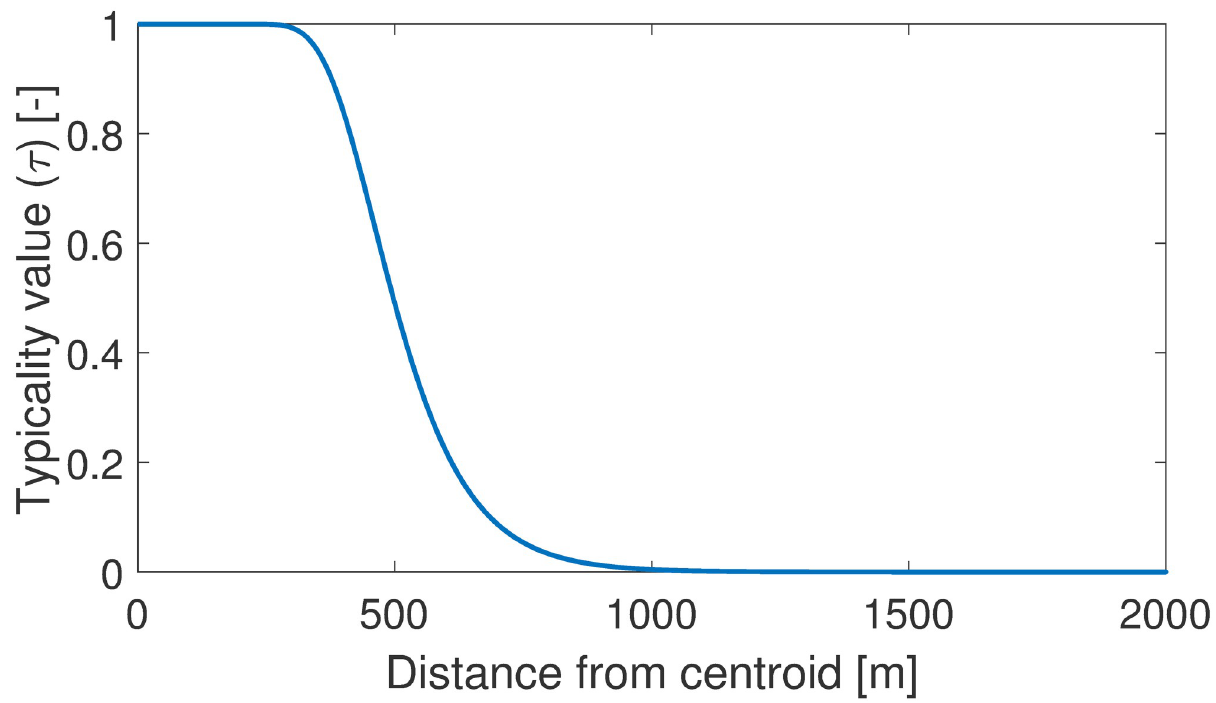
Fig 3. The typicality function represents the willingness of passengers to walk to a nearby public transportation stop. This function implicitly determines how many clusters are needed to group rides nearby the transportation lines.